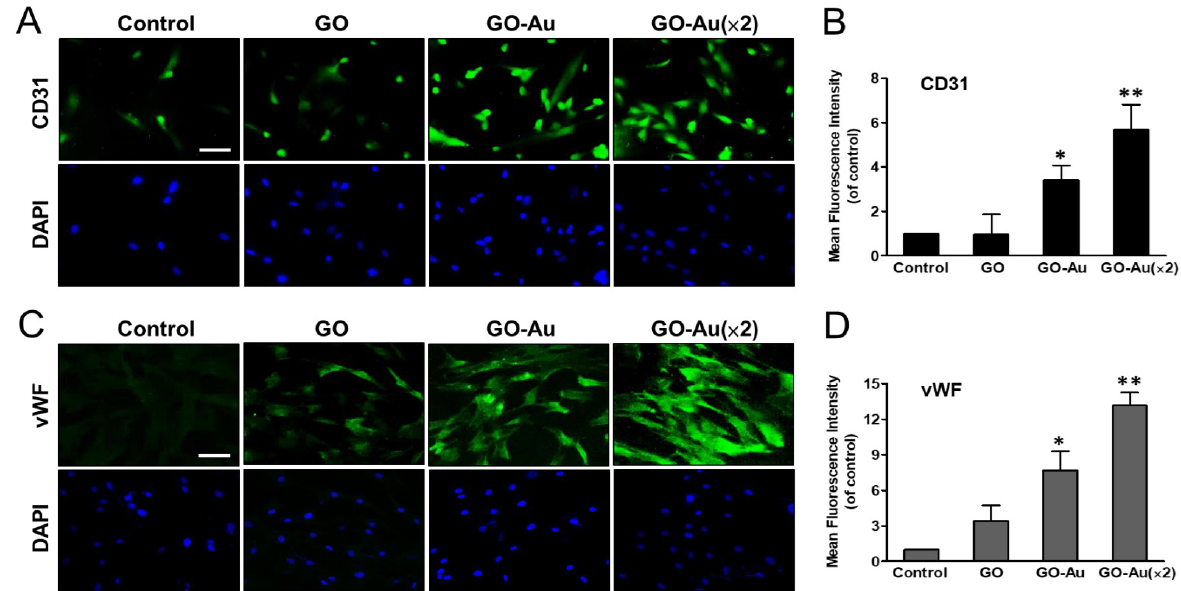
Figure 7. Identification of GO-Au-mediated MSC differentiation into endothelial cells. Cells were cultured on various nanomaterials of GO, GO-Au, and GO-Au ( × 2) for 7 days. Then, cells were analyzed for the expression levels of ( A , B ) CD31 and ( C , D ) vWF, using an immunofluorescence assay. Scale bar, 20 µ m. The quantification of fluorescent intensity in CD31 and vWF protein expression. Data were presented as the mean ± SD. * p < 0.05 and ** p < 0.01.